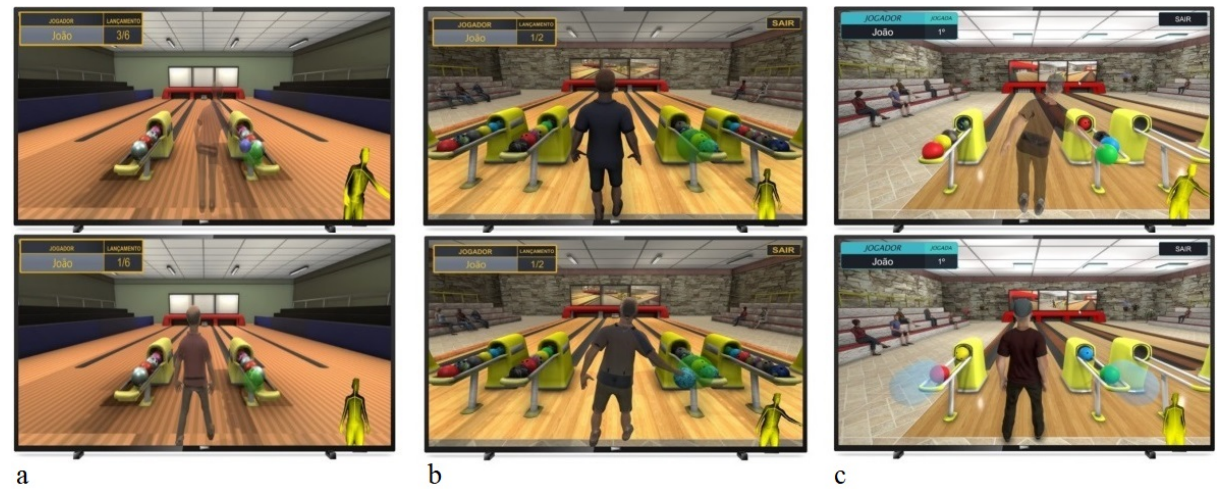
Figure 1. Screenshots showing the evolution of the bowling exergame versions in its (a) first version, (b) intermediate version, and (c) final version.